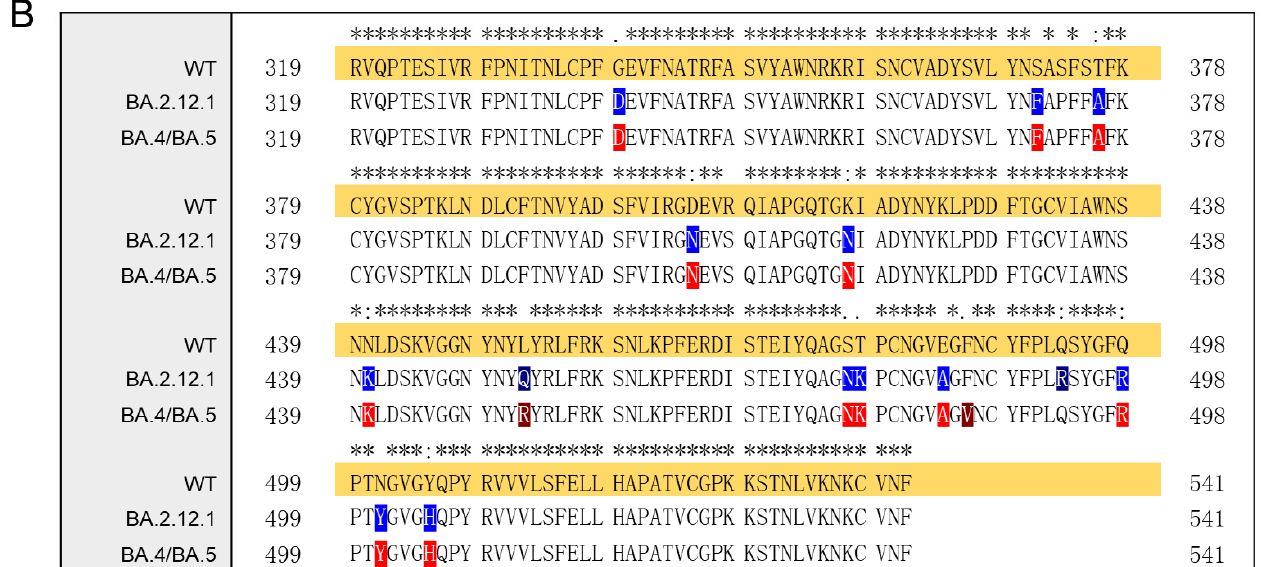
Figure 1. Phylogenetic tree and multiple sequence alignment. ( A ) Phylogenetic relationships of Nextstrain SARS-CoV-2 clades. The phylogenetic tree was adapted from figure provided by Nextstrain and CoVariants [29]. VOCs are represented by colored nodes. ( B ) Mutation profile of S protein RBD of Omicron BA.2.12.1, BA.4/BA.5 compared with WT. Multiple sequence alignment was performed by Clustal Omega (1.2.4). An * (asterisk) indicates positions which have a single, fully conserved residue.